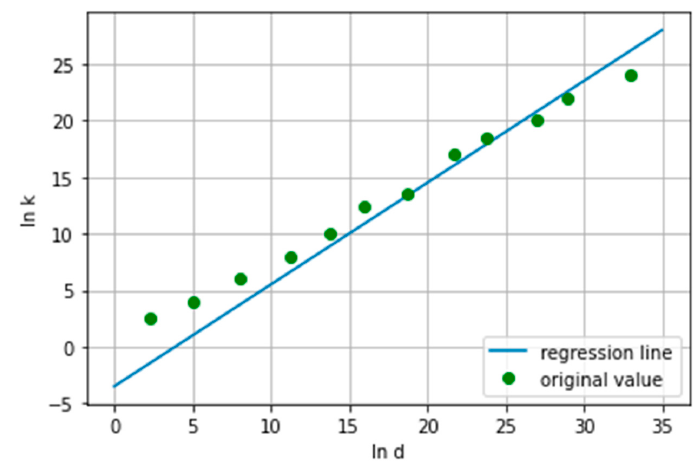
Figure 2. Dependence of the size of cells on their number for material 1.